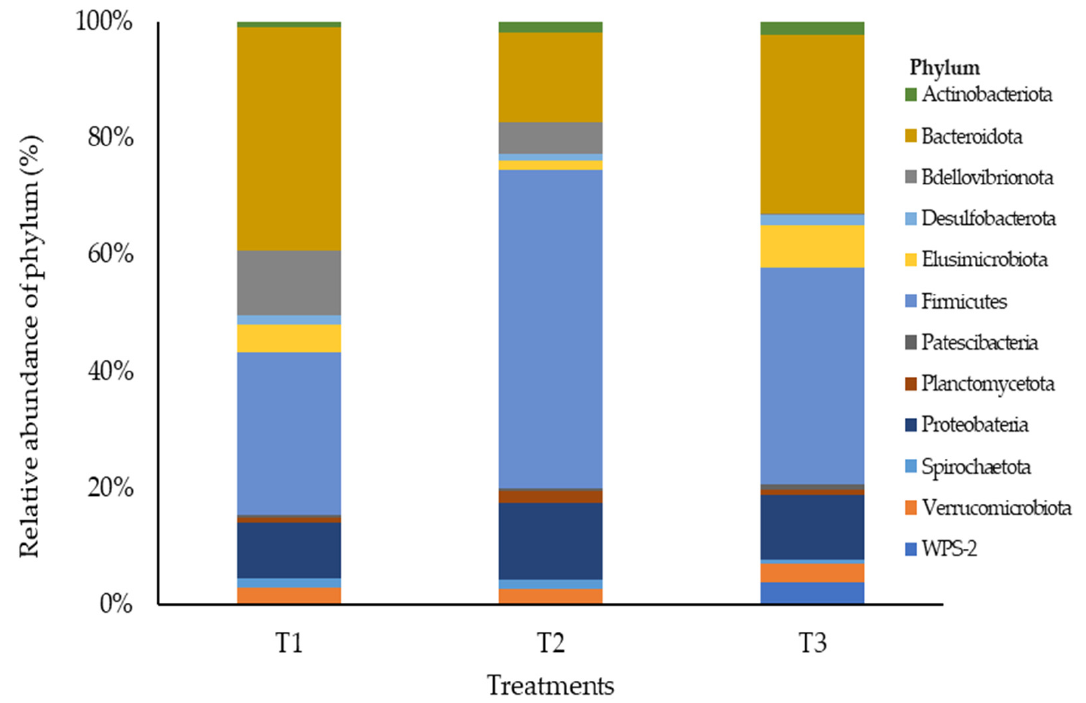
Figure 2. Bacterial relative abundance (>1% at least in one group) at phylum level as influenced by the sprout supplementation on meat-master lambs.